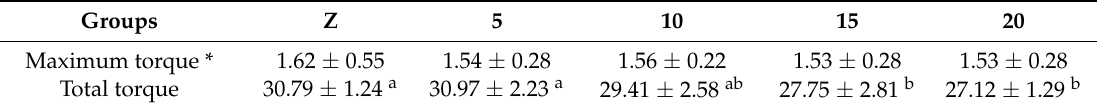
Table 1. Maximum and total torque (N ⋅ cm) generated during instrumentation after repetitive insertions of glide-path instruments at the working length (mean ± SD).